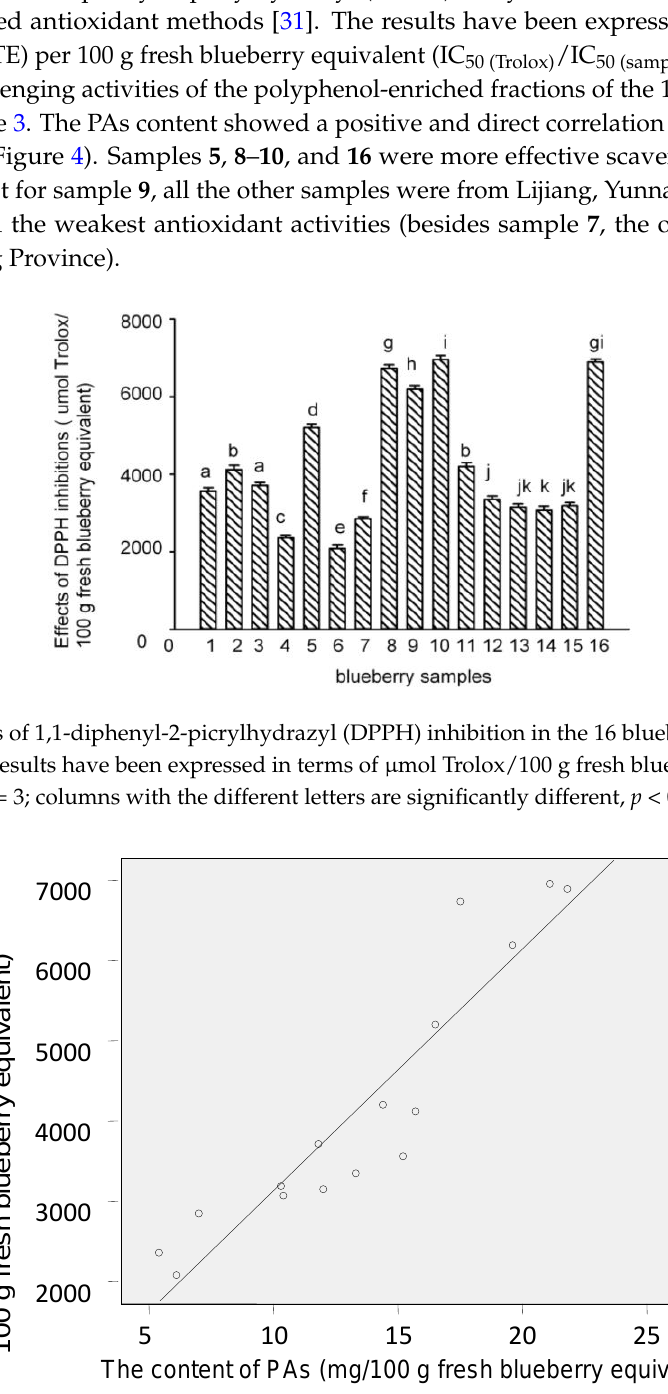
Figure 4. Pearson’s correlation between PAs content and antioxidant capacity (DPPH) of the 16 blueberry polyphenol fractions (Pearson’s correlation coefficient ( r ) = 0.926, significance at p = 0).